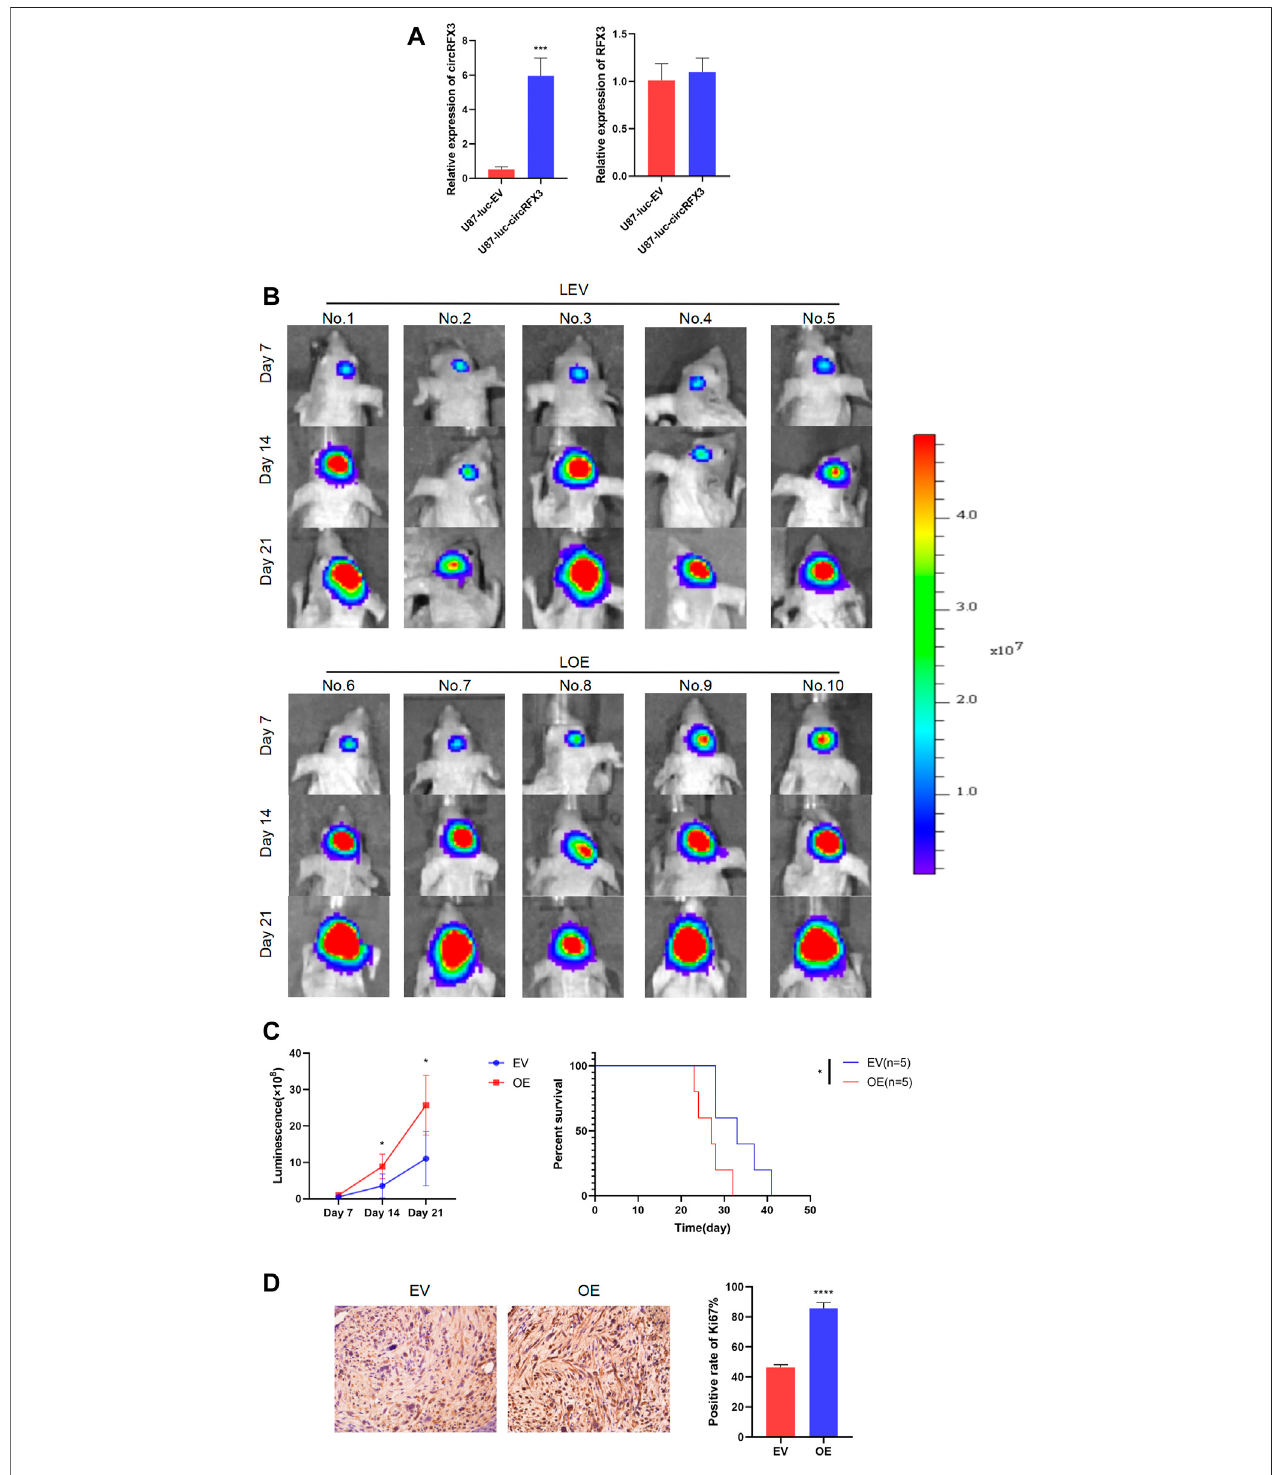
FIGURE 3 | circRFX3 promoted glioblastoma growth in vivo . (A) The qRT-PCR results showed that circRFX3 was obviously overexpressed in U87-luciferase- circRFX3 overexpression vector (LOE) cells, while RFX3 mRNA did not change. (B,C) The outcomes of in vivo imagingofsmallanimals showed that tumor growth in the LOE group was clearly accelerated compared with that in the U87-luciferase-empty vector (LEV) group. The survival times of mice in the LOE group were much shorter thanthoseintheLEVgroup. (D) TheresultsofimmunohistochemistrystainingshowedthattheexpressionofKi67wasobviouslyboostedbytheoverexpressionof circRFX3. Statistical analysis was conducted with Student ’ s t -test. * p < 0.05.